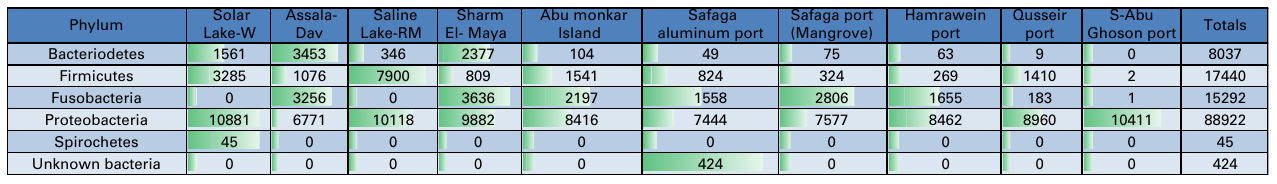
Table 3 | Total number of reads assigned at the phylum level in Red Sea coastal samples and two lakes.